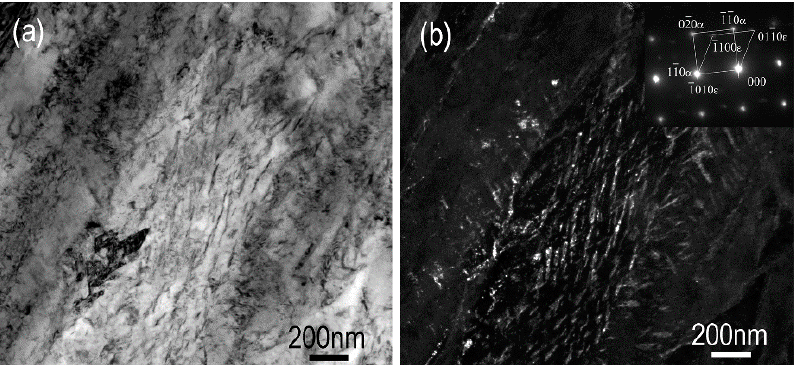
Figure 6. ( a ) BF and ( b ) DF micrographs of transition carbides at 200 °C, the corresponding SAED pattern inserted in ( b ).